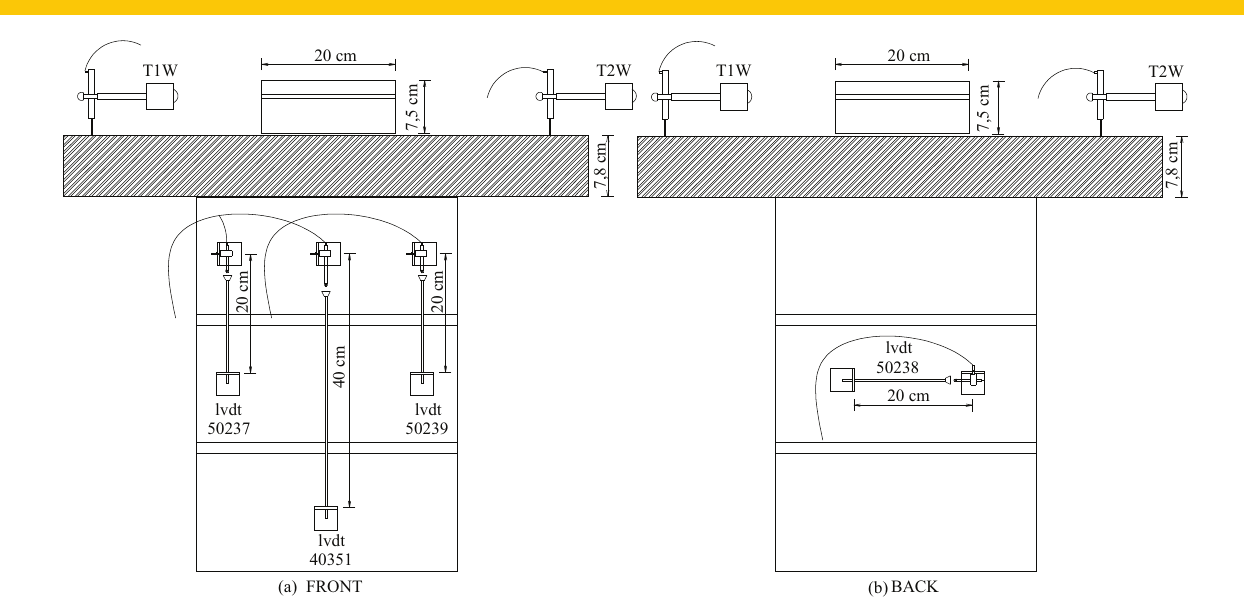
Figure 5 – Positioning of the LVDTs in the tests with prisms comprising three whole blocks (type A)